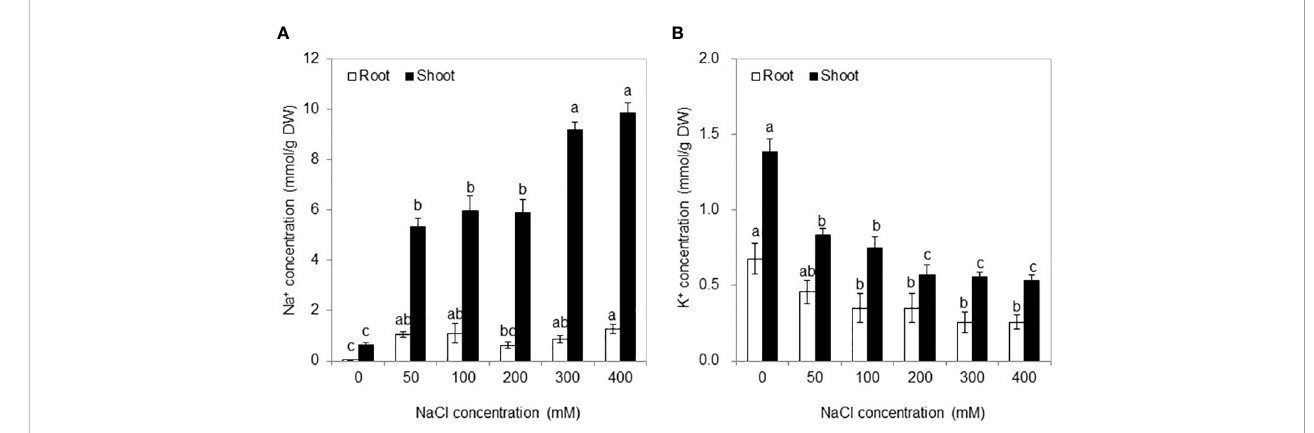
FIGURE 3 Na + (A) and K + (B) concentrations in the roots and shoots under different NaCl concentrations for 30 days. Values are means ± standard errors (SE) ( n = 4), and bars indicate SE. Signi fi cant differences between columns in the roots and shoots are indicated by different lowercase letters (Duncan ’ s test, p < 0.05).